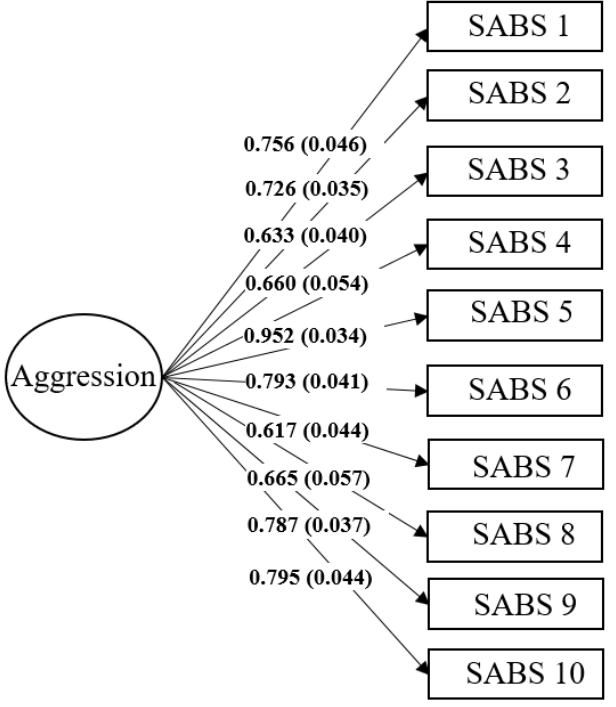
Figure 1. The single factorial structure of the Portuguese Version of SABS for CFA Male sample. Values represent standardized regression weights and standard error within brackets .